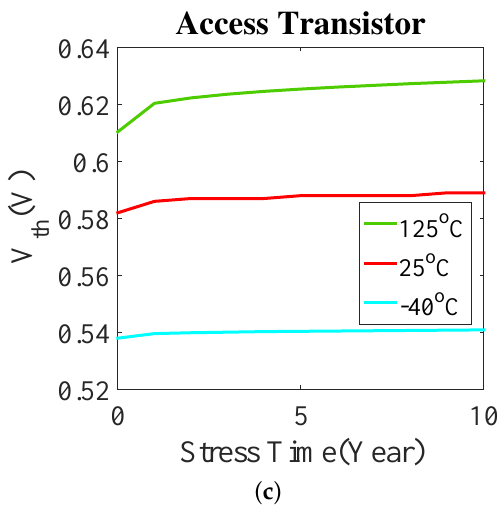
Figure 15. Degradation in V th of SRAM cell transistors in 10 year NBTI & PBTI stress. Table 1. Process Corner and leakage currents.